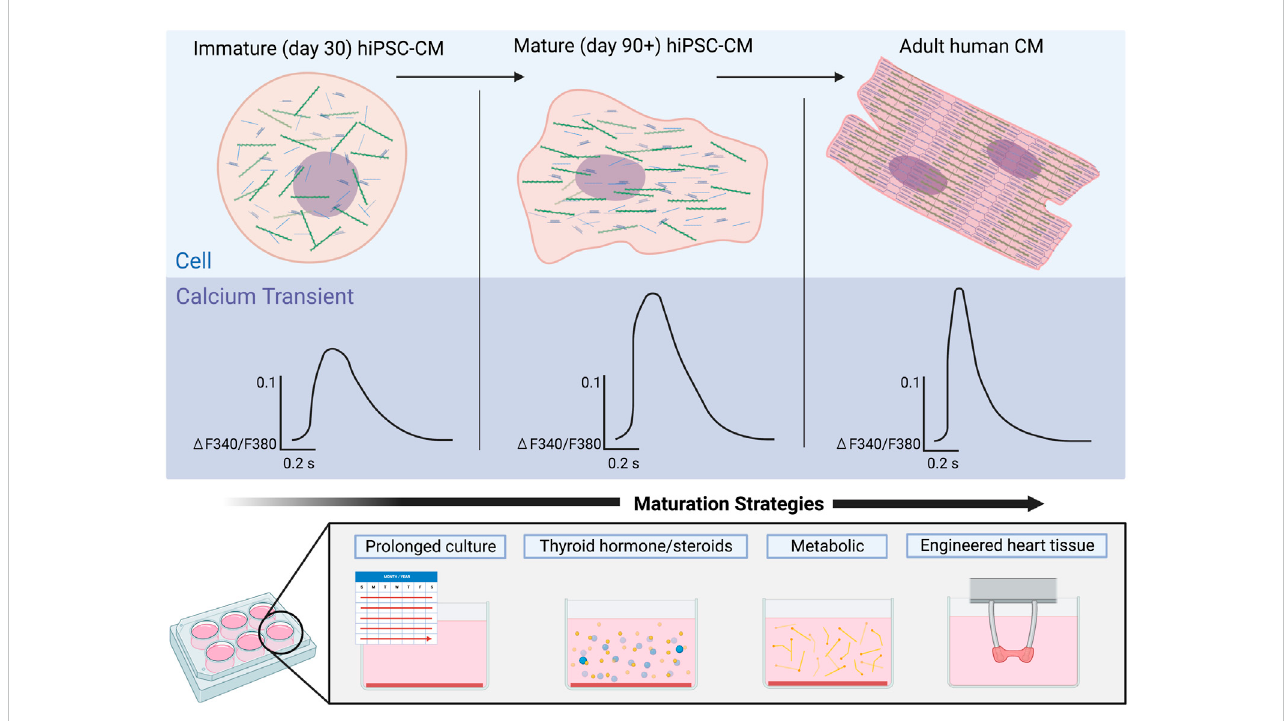
FIGURE 3 Maturation of calcium signaling in hiPSC-CMs over time in comparison to adult human cardiomyocytes. Early hiPSC-CMs (left) lack the structural organization of adult CMs (right), an immaturity re fl ected in their respective Ca 2+ transients. Ca 2+ transients of immature hiPSC-CMs exhibit a smaller amplitude as well as much slower rise times and recovery rates. Maturation of the hiPSC-CMs (middle) results in increased structural organization of the cells and Ca 2+ transients with larger amplitudes and faster rise times and recovery rates. Strategies to mature Ca 2+ handling in hiPSC-CMs will be critical to achieve more adult human like Ca 2+ transients.